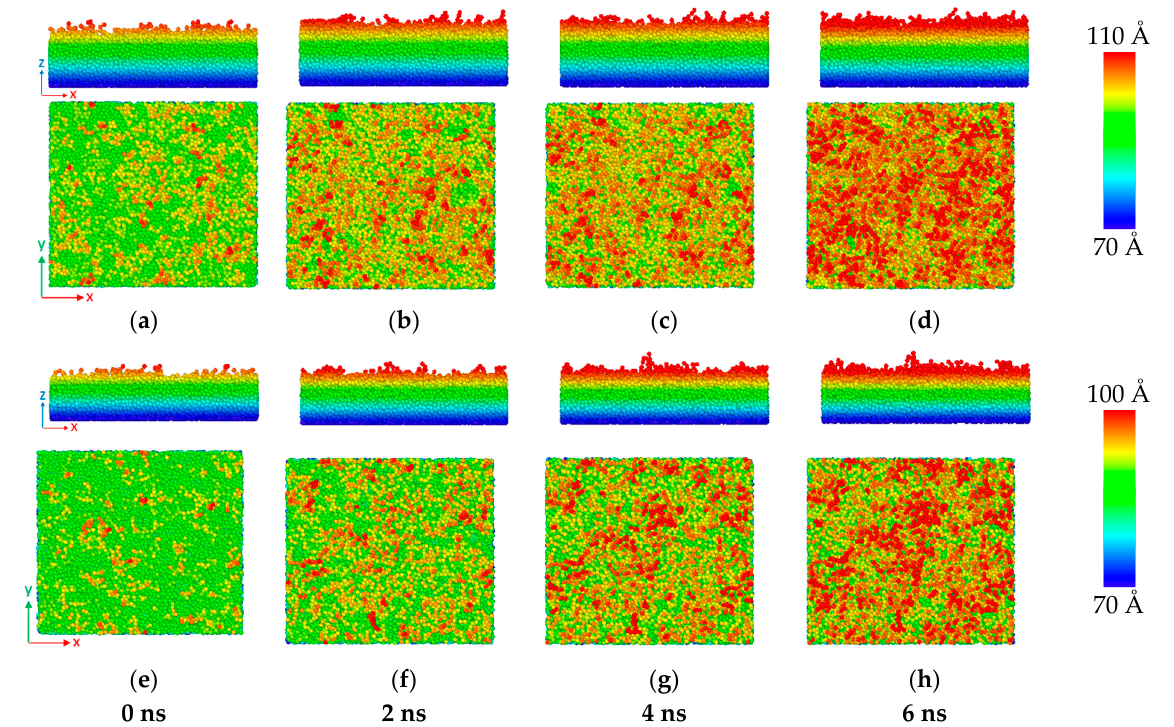
Figure 2. Front and top views of the atomic configurations of Al atoms in the C-terminated ( a ) to ( d ) 6H-SiC/Al and ( e ) to ( h ) 3C-SiC/Al interfaces with 20% vacancy in SiC after maintaining the systems for 0, 2, 4, and 6 ns at 1000 K. The color represents the z -coordinate of Al atoms near the interface.